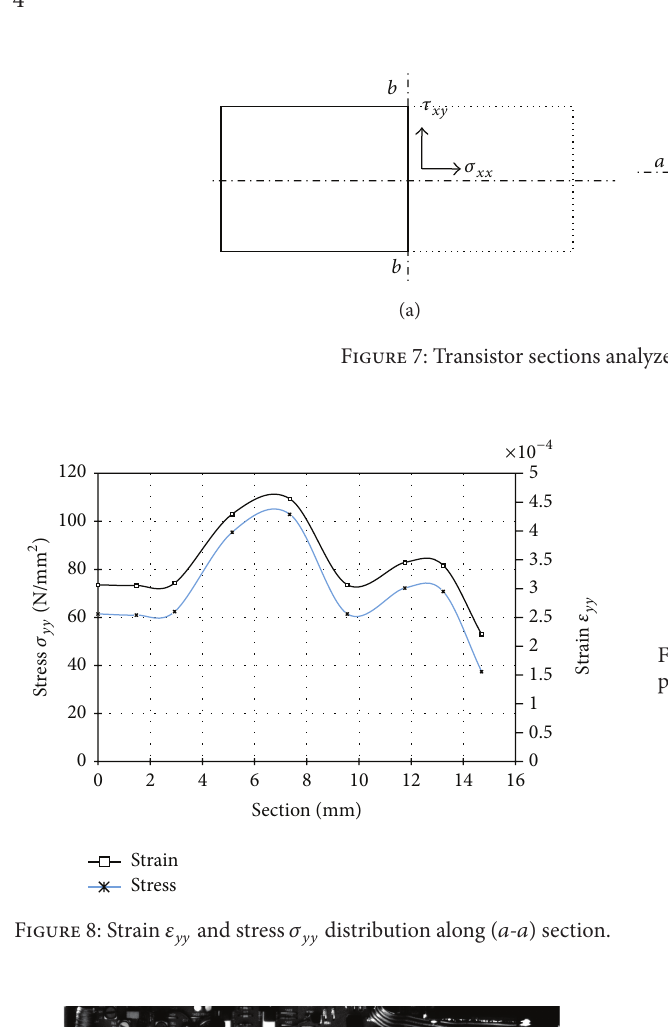
constraints (metallic welded plates). The maximum 𝜎 𝑦𝑦 value